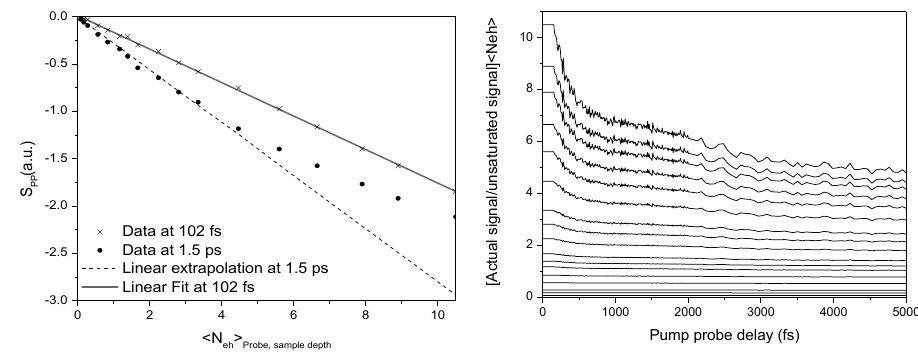
Fig.3 (left) 8 nm diameter PbS dot pump-probe signals at 102 fs (cross) and 1.5 ps (solid circle) as a function of <N eh >. Fig.4 (right) Saturation of the pump-probe signal (signal divided by the linear extrapolation from the low power signal at each pump-probe delay) as a function of pump-probe delay. Since the signal for delays near time zero is proportional to <N eh >, each curve was multiplied by the initial <N eh